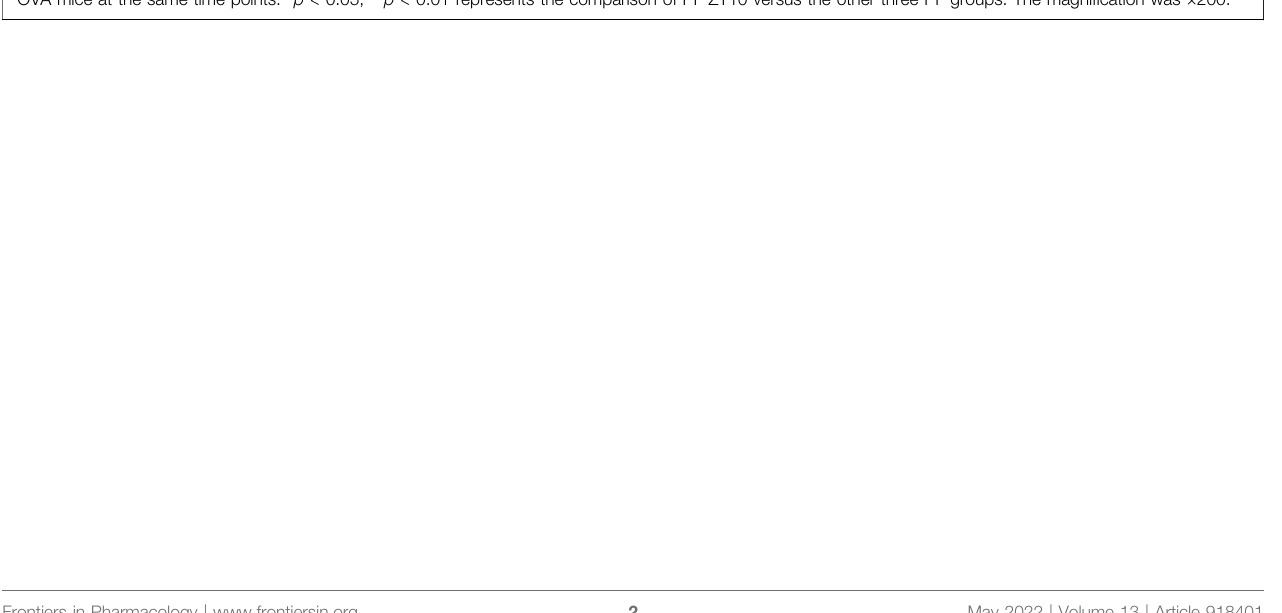
Frontiers in Pharmacology |